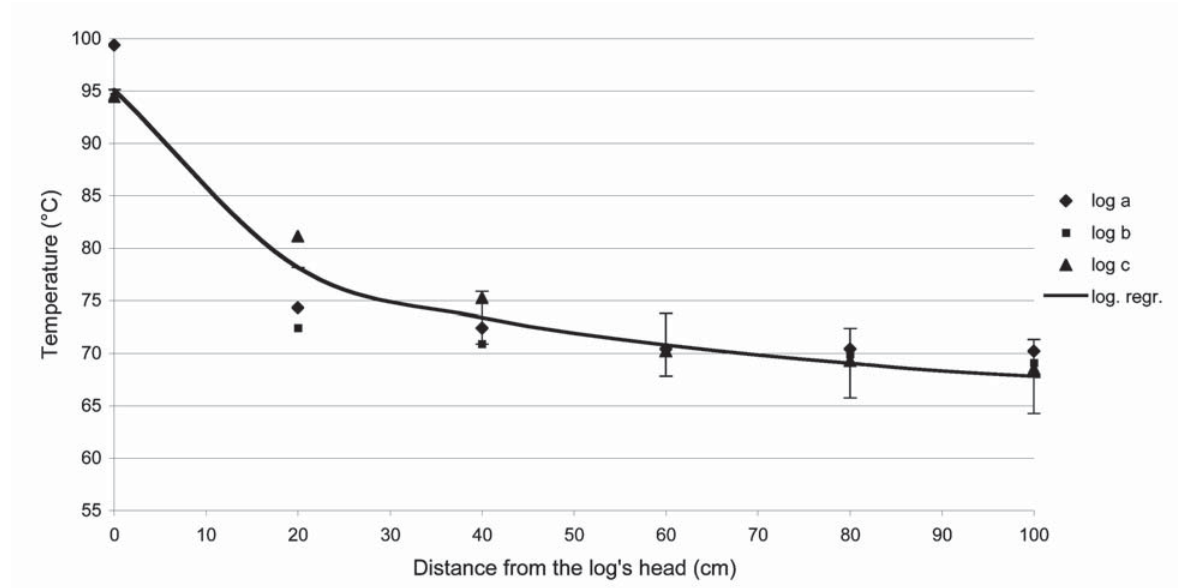
Fig. 1. Temperature variation with the distance from the head of a log after 120 min at 30 mm depth. Confidence intervals refer to the equation y=87.09517–44.1918 ln (ln x) (R 2 =0.94).